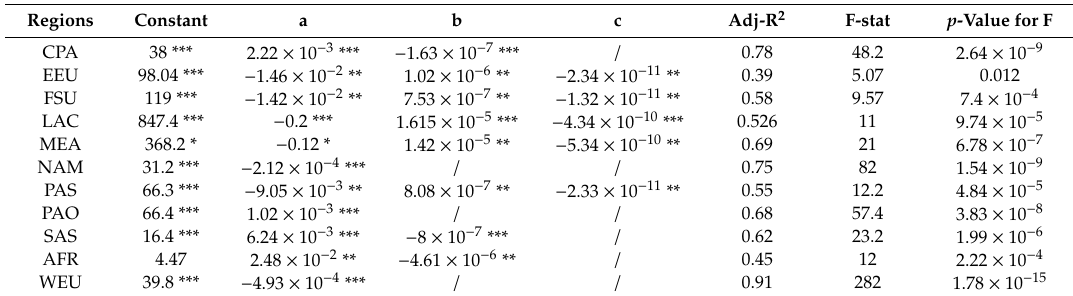
Table 4. The regression results for the 11 regions.